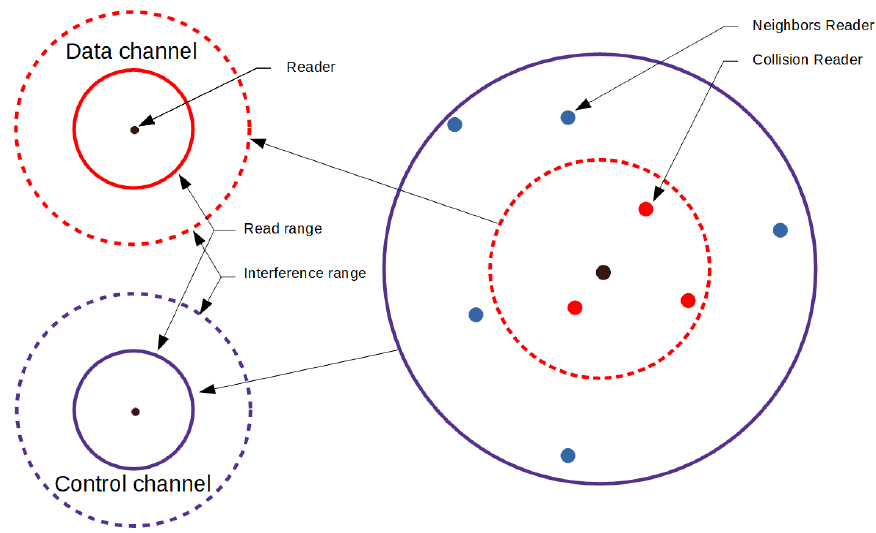
Figure 3. Basic architecture proposed for the RFID reader.